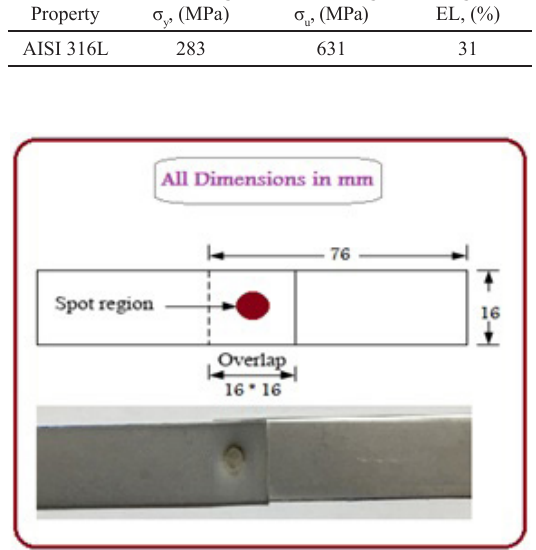
Figure 1. Sample of